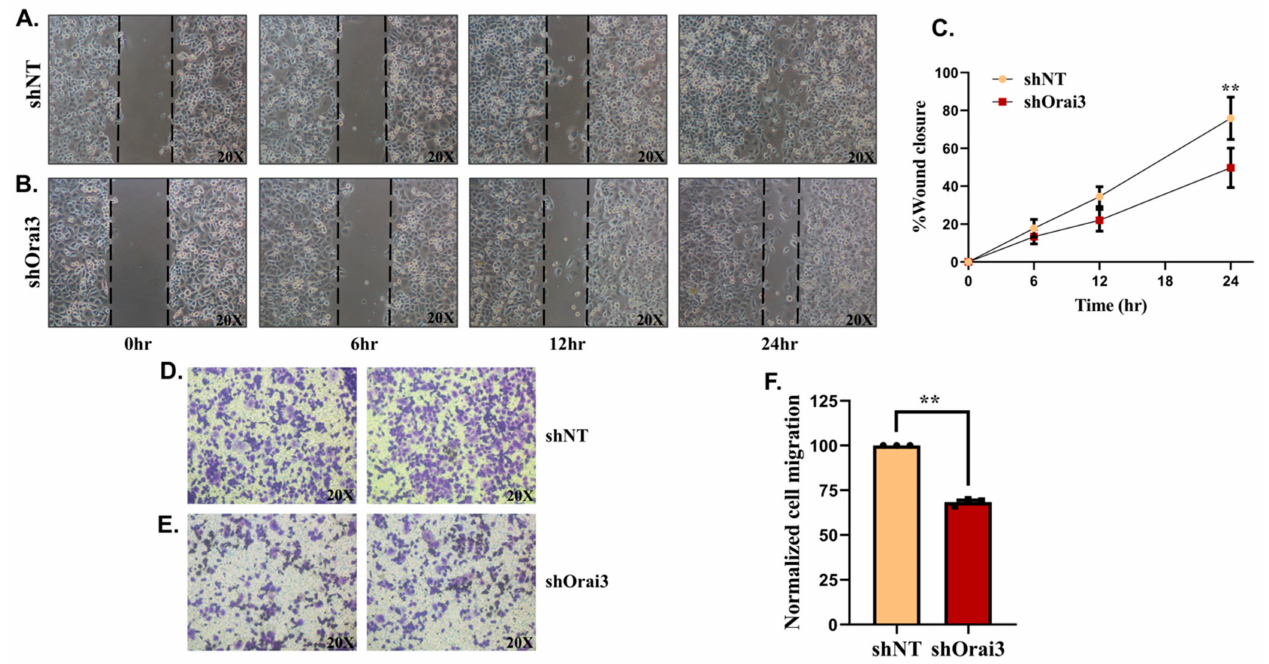
Figure 7. Orai3 controls migration of Panc1 cells. Scratch wound healing ( A – C ) and transwell migration assays ( D – F ) were performed for evaluating the role of Orai3 in regulating Panc1 migration. ( A ) Representative wound healing images at 0, 6, 12 and 24 h time points in the case of shNT Panc1 stable cells. ( B ) Representative wound healing images at 0, 6, 12 and 24 h time point in case of shOrai3 Panc1 stable cells. ( C ) Quantitative analysis of %wound healing over the period of 24 h in shNT and shOrai3 Panc1 stable cells from 4 independent experiments. ( D ) Representative micrographs of crystal violet stained transwell migrated shNT Panc1 stable cell line. ( E ) Representative micrographs of crystal violet stained transwell migrated shOrai3 Panc1 stable cells. ( F ) Quantitative analysis of number of migrated cells in the transwell migration assay from three independent experiments. Data presented as mean ± S.E.M. Unpaired Student’s t -test was performed for statistical analysis. p -value < 0.05 was considered as significant and p -value < 0.01 is denoted as